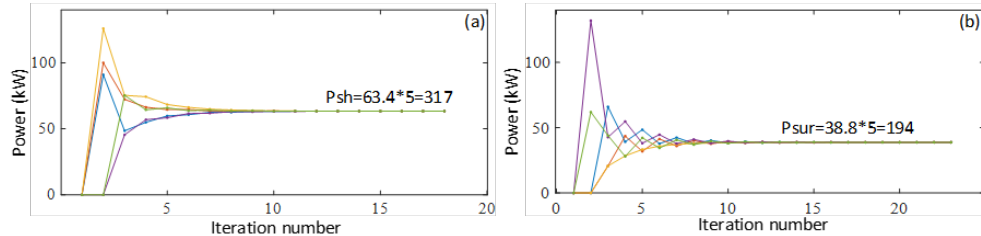
Figure 8. Information sharing (case 1): ( a ) shortage power information; ( b ) surplus power information.